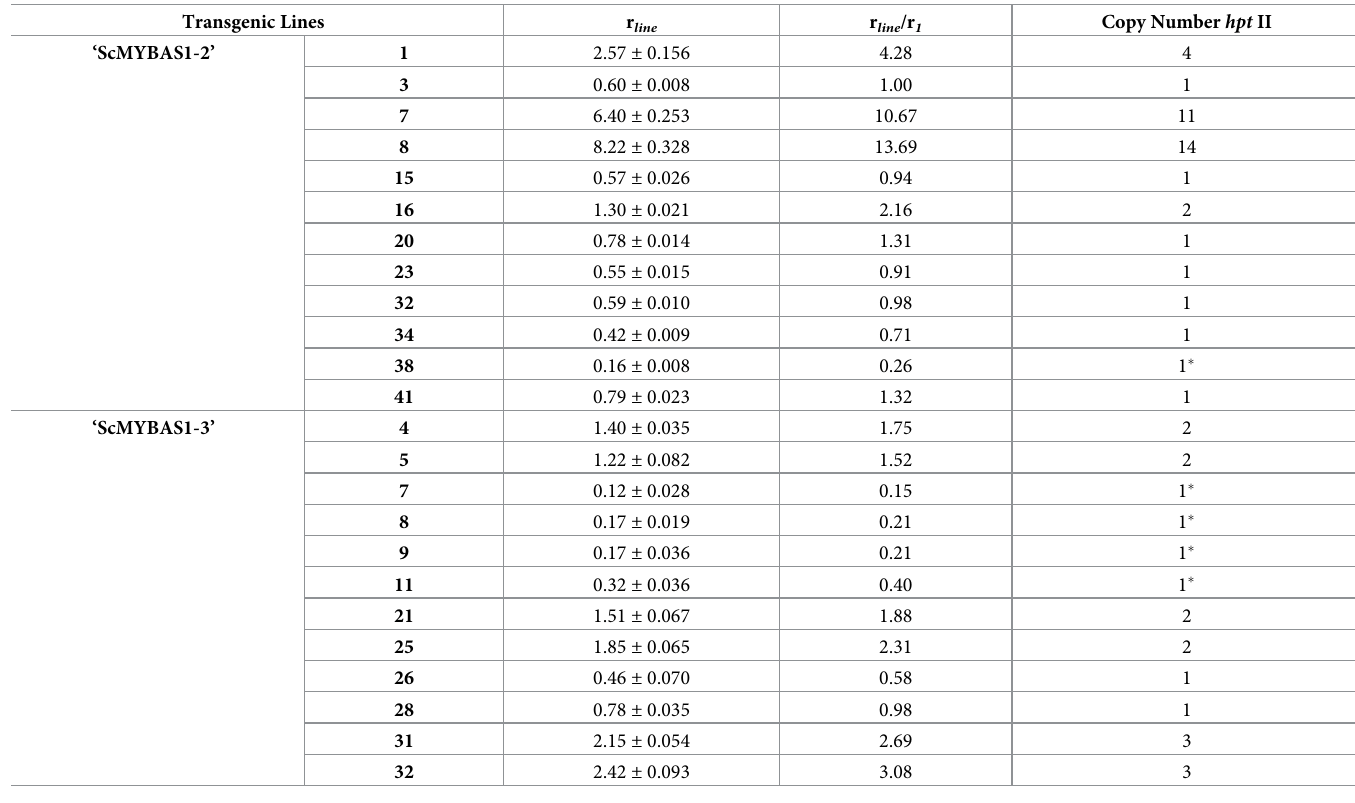
Table 2. Taqman qPCR estimates of copy number for hpt II transgene of ScMYBAS1-2 and ScMYBAS1-3 transgenic plants. Transgenic Lines r